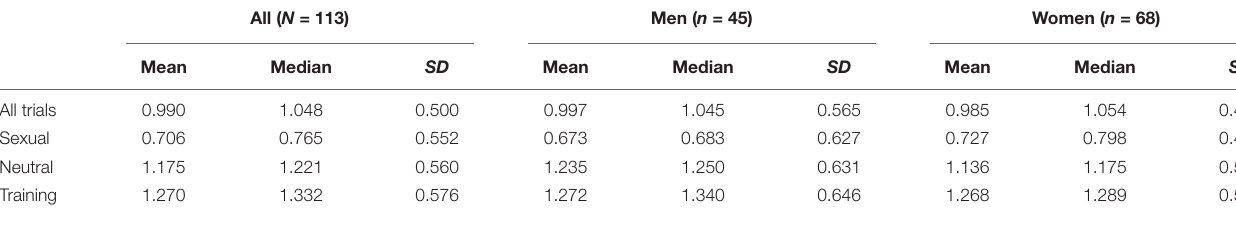
TABLE 5 | Picture recognition task: Mean response bias index c , median, and SD